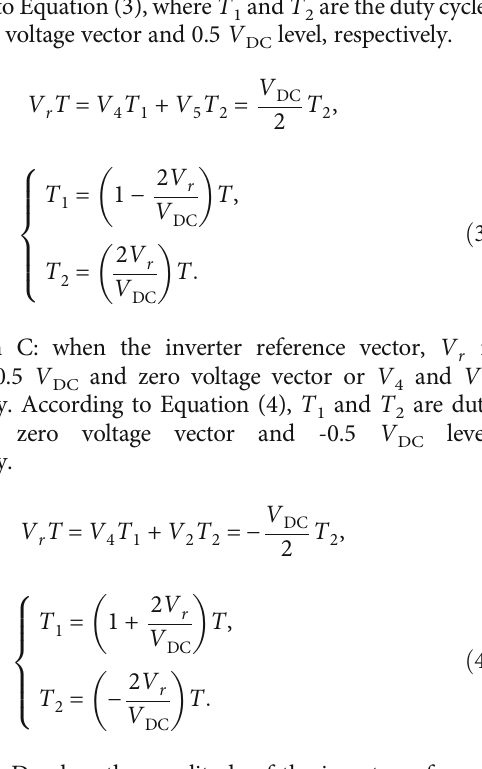
and - V voltages or V DC DC